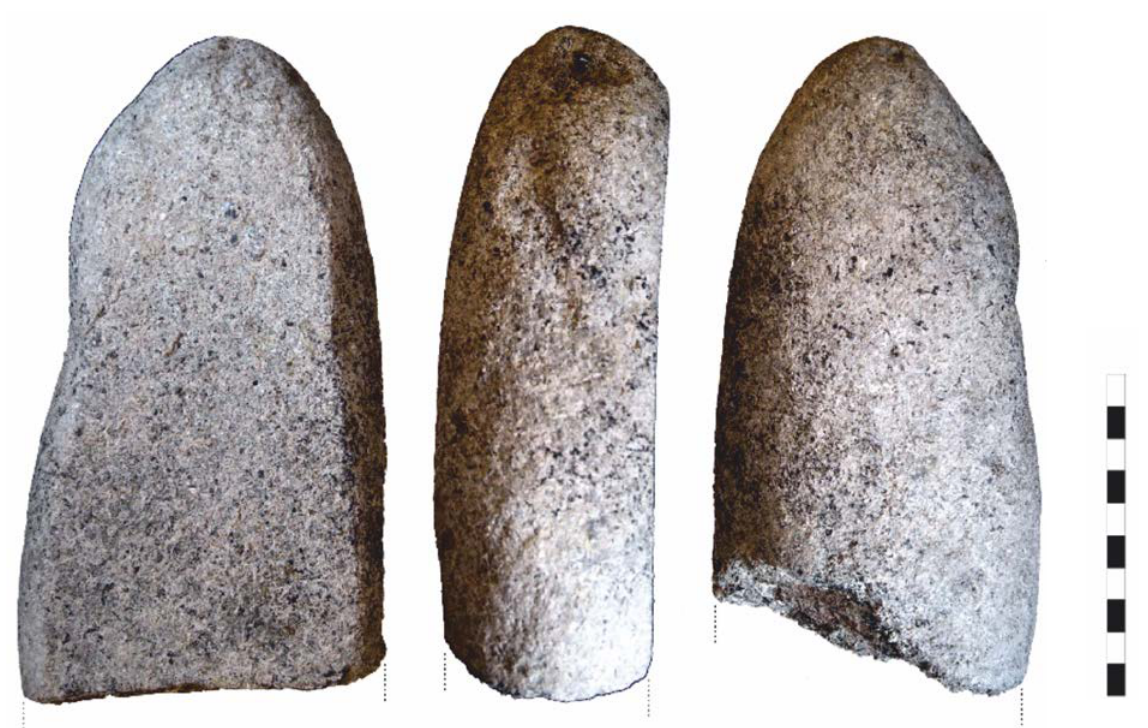
Figure 3. Grinder: workface, profile and dorsal face (scale in